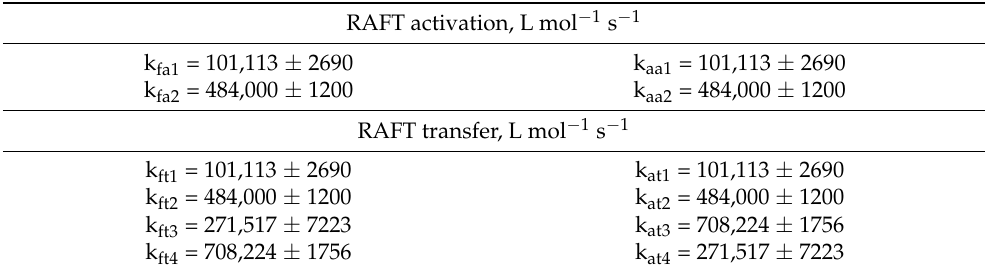
Figure 6. Copolymer composition versus time profiles for the different St-GMA samples. Symbols represent experimental data, whereas solid lines correspond to model predictions. Table 10. AA termination parameters determined in this study. Table 9. Activation and transfer kinetic rate constants evaluated in this